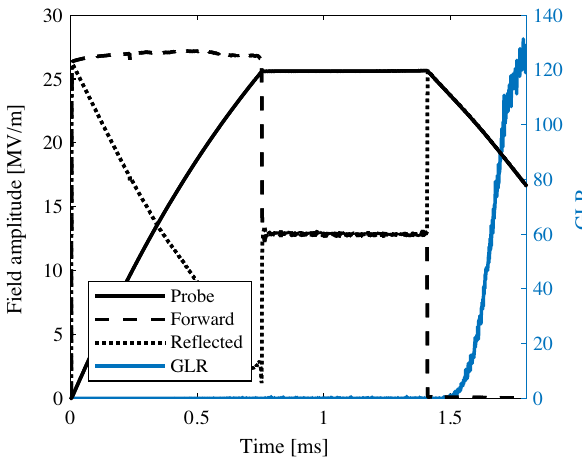
FIG. 5. Quench signals for pulse 1 from Fig.